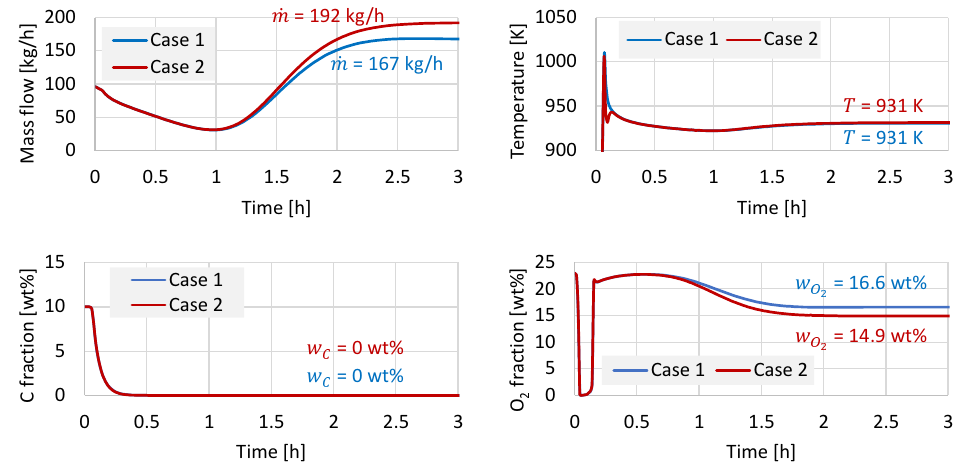
Figure 19. Time-dependent change in mass flow ( top left ), temperature ( top right ), and concentration of organic residues ( bottom left ), in the solids outlet stream of Calciner 2 (Product stream in Figure1), and change in residual oxygen concentration ( bottom right ) after combustion in the gas outlet stream (Out calciner gas 2 stream in